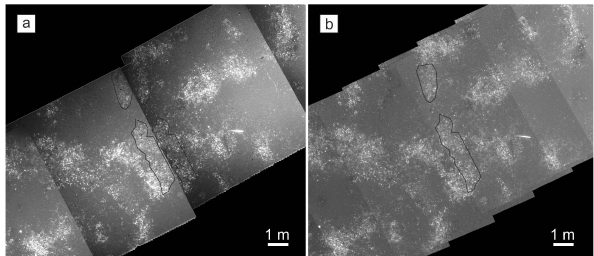
Fig. 1. Two photo-mosaics of a same area, constructed with differ- ent methods. The photo-mosaics represent clam aggregates on soft sediments. (a) Navigation-based photo-mosaic; mismatches occur between consecutive images. (b) Feature-based photo-mosaic; bet- ter fit between consecutive images; however, more images are re- quired to cover the same